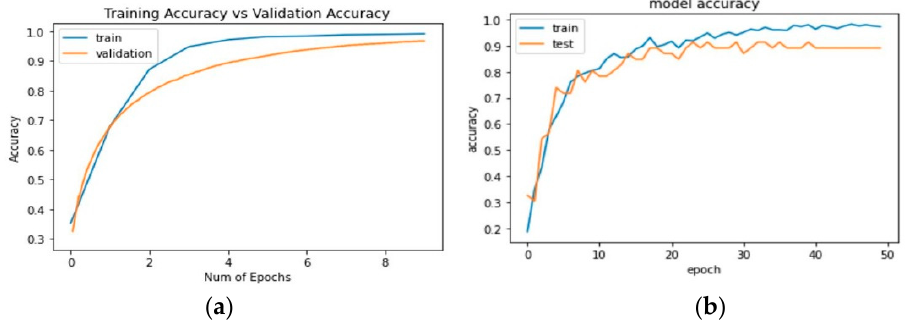
Figure 8. Plots of training and validation accuracy of the networks: ( a ) LSTM NN and ( b ) Res- Net34.